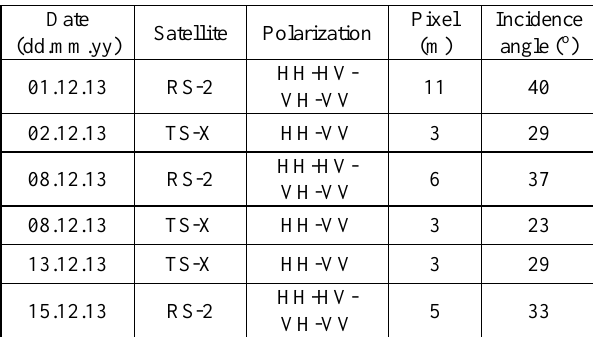
Table 1. List of SAR data used in this work. Abbreviations: RS- 2 for RADARSAT-2 and TS-X for